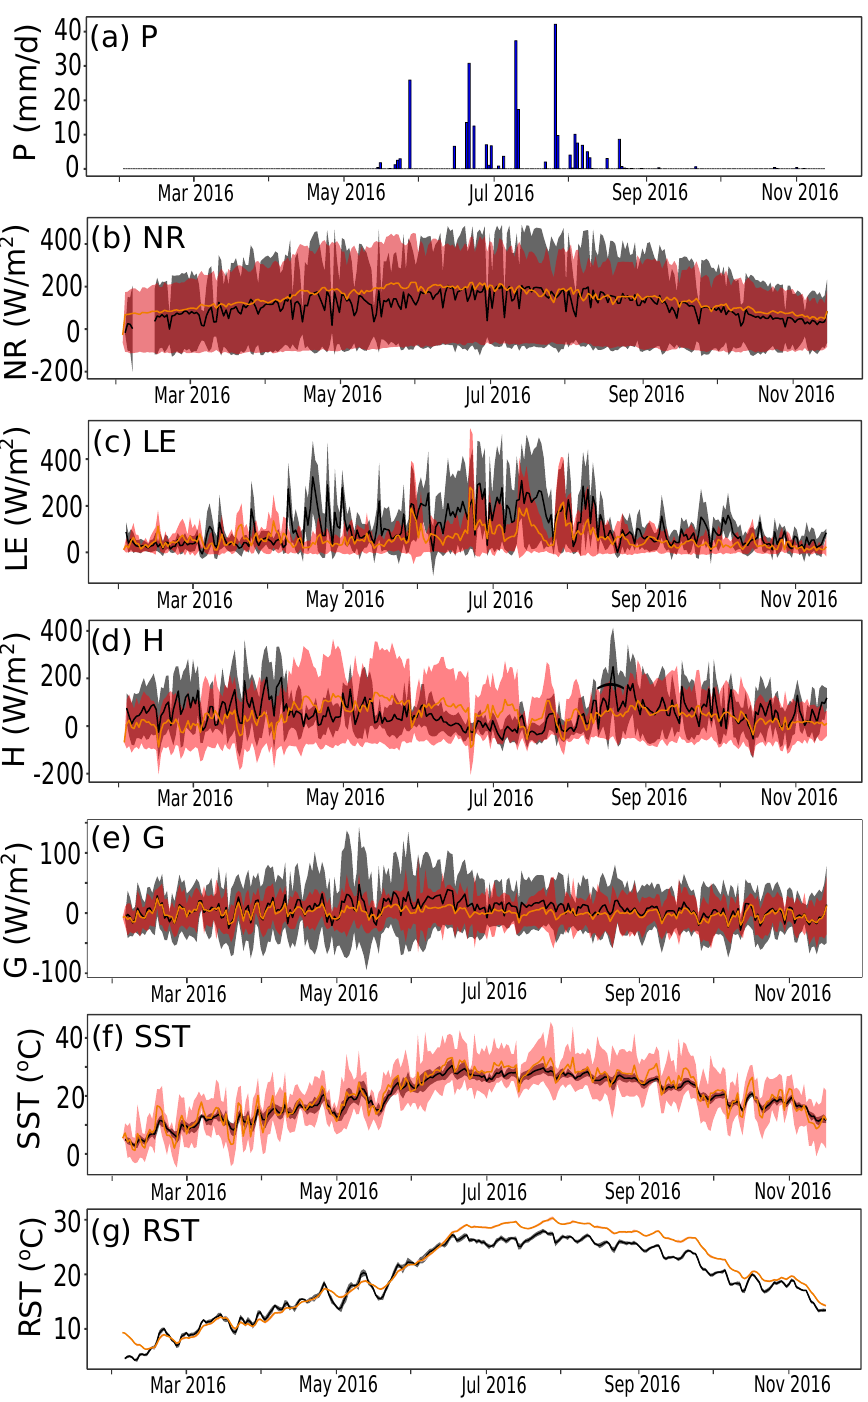
Figure 11. Daily-aggregated time series of ARM-CF to ARM-A74 parameter transferability experi- ments vs. observations: ( a ) precipitation (P; blue bars), and simulated (orange) and observed (black) ( b ) net radiation (NR, W/m 2 ), ( c ) latent heat flux (LE, W/m 2 ), ( d ) sensible heat flux (H, W/m 2 ), ( e ) ground heat flux (G, W/m 2 ), ( f ) soil surface temperature (SST, ◦ C), and ( g ) root-zone soil temperature (RST, ◦ C). Daily standard deviation envelopes (pink for simulated and grey for observed) were added to both time series to illustrate sub-daily